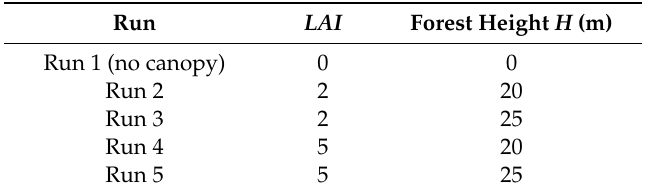
Figure 11. Big domain 20 km × 20 km ( a ). The color indicates the type of classes used in the simulation: red for urban, grey for ground, and green for forest. The black box shows the position of the small domain 5 km × 5 km ( b ). Table 5. Summary of simulations run to investigate the sensitivity of the model to the LAI and forest height H